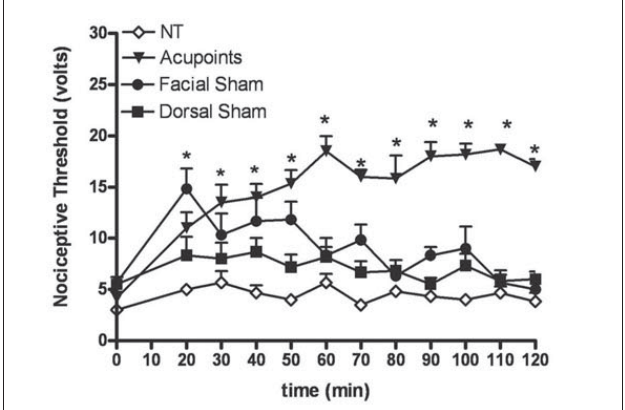
Fig. 1. Evaluation of differences among acupoints and facial and dorsal sham points on the analgesic effect of low-frequency electroacupuncture (EACP) in rabbit tooth pulp assay. The nociceptive threshold was measured before and after EACP procedure, every 10 min up to 120 min. Animals were treated with EACP at acupoints (Acupoints; Yintang, ST4, ST5; 2 Hz, 30 mA; 20 min before test up to 120 min), facial sham points (Facial Sham; 2Hz, 30 mA; 20 min before test up to 120 min) and at back sham points (Dorsal Sham; 2Hz, 30 mA; 20 min before test up to 120 min). NT represents non-treated animals. The points represent the means ± SEM of 6 animals per group. Asterisks indicate statistically significant differences between the NT group and the others (*p<0.05; ANOVA followed by Turkey’s test).